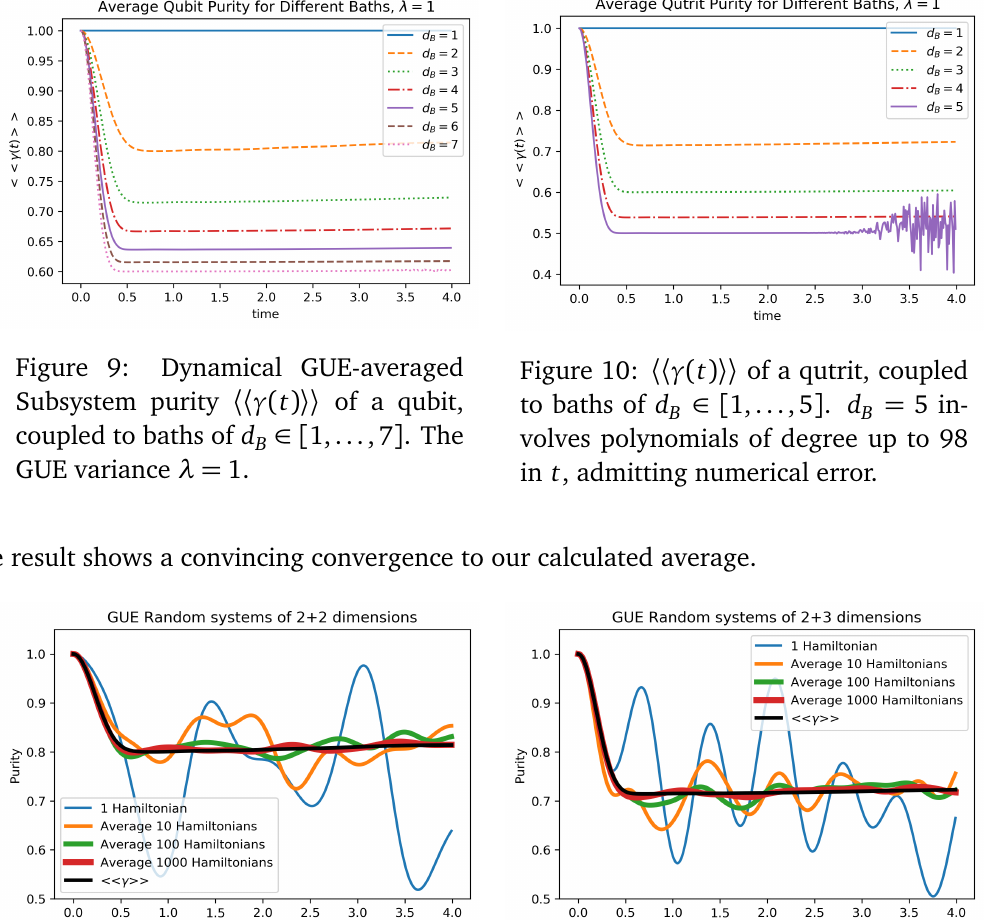
Figure 12: Numerical average purity: a qubit-qutrit system for growing samples of GUE-Hamiltonians. In black the ana- lytic 〈〈 γ ( t ) 〉〉